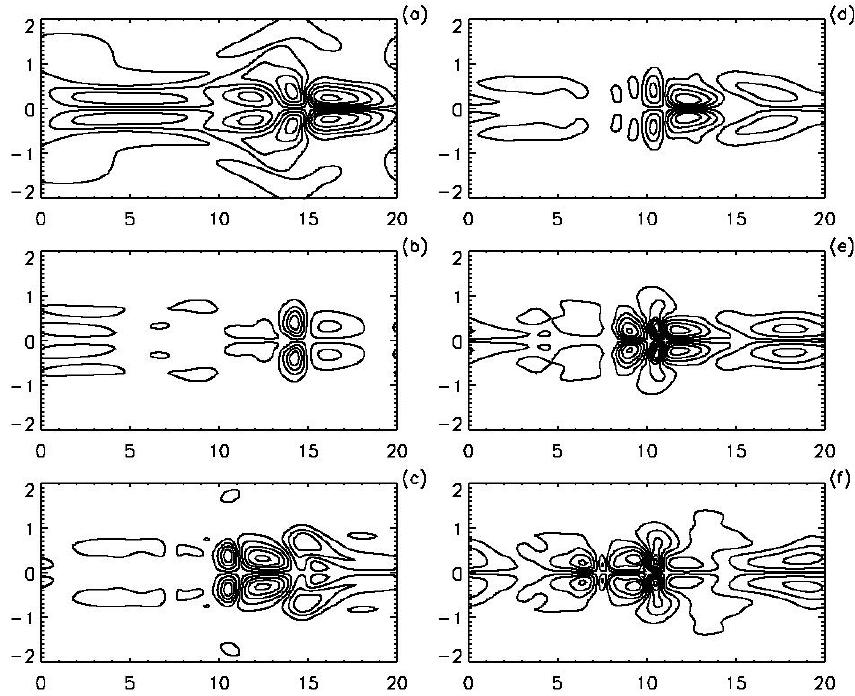
Fig. 8. Deep domain cosine duct temperature contours for increased amplitude initial perturbation. Times are 38, 51, 79, 88, 94, 103.